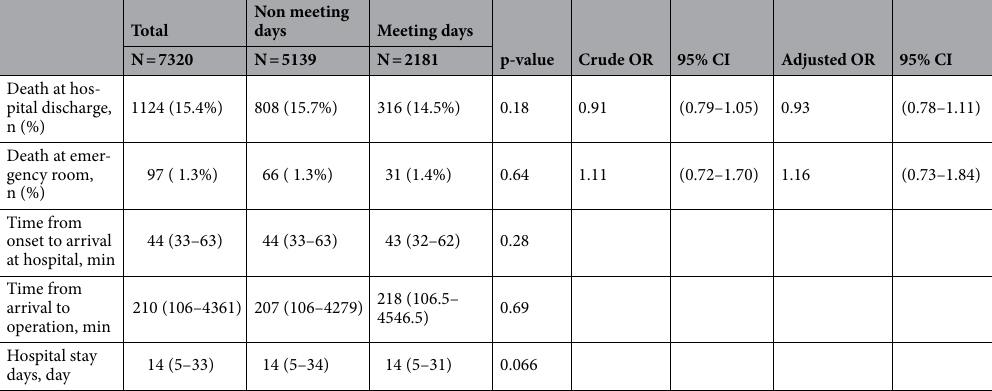
Table 2. Outcomes between meeting and non-meeting days. OR odds ratio, CI confidence interval.